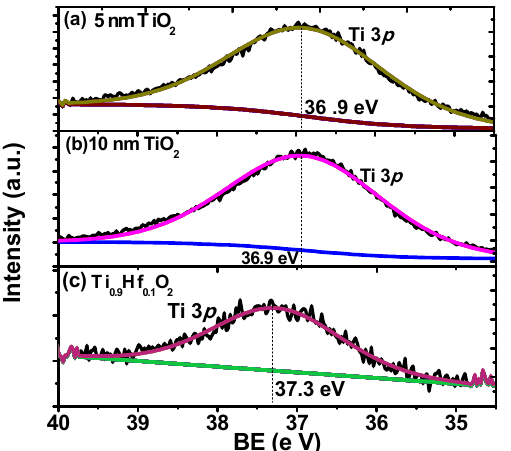
Figure 2. The Ti 3 p spectra from: ( a ) 5 nm TiO 2 ; ( b ) 10 nm TiO 2 ; and ( c ) 5 nm Ti 0.9 Hf 0.1 O 2 thin films. The 5 nm and 10 nm thickness TiO 2 samples share the same Ti 3 p 3/2 binding energy centered at the 36.9 eV. A small difference, 0.4 eV, is observed in binding energy of Ti 3 p spectra between TiO 2 at 36.9 eV and in the Ti 0.9 Hf 0.1 O 2 samples at 37.3 eV.